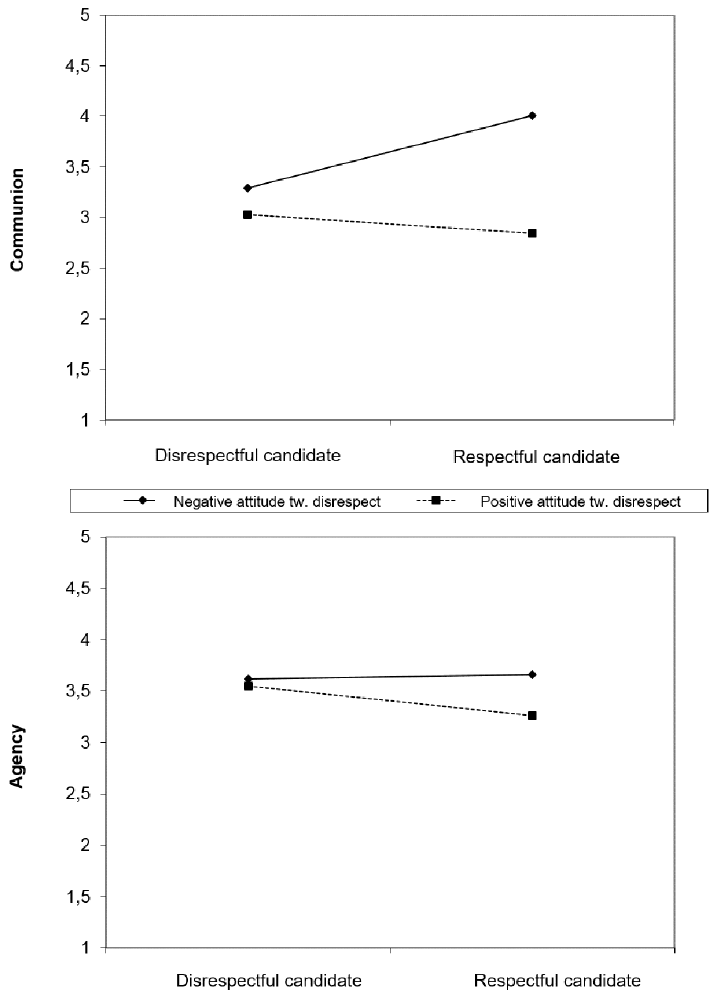
Figure 3. Simple slopes for the interaction effect of disrespectful vs. respectful candidate behavior and participants’ attitude towards disrespect on their communion and agency judgments of the candidate in Study 2 (N =